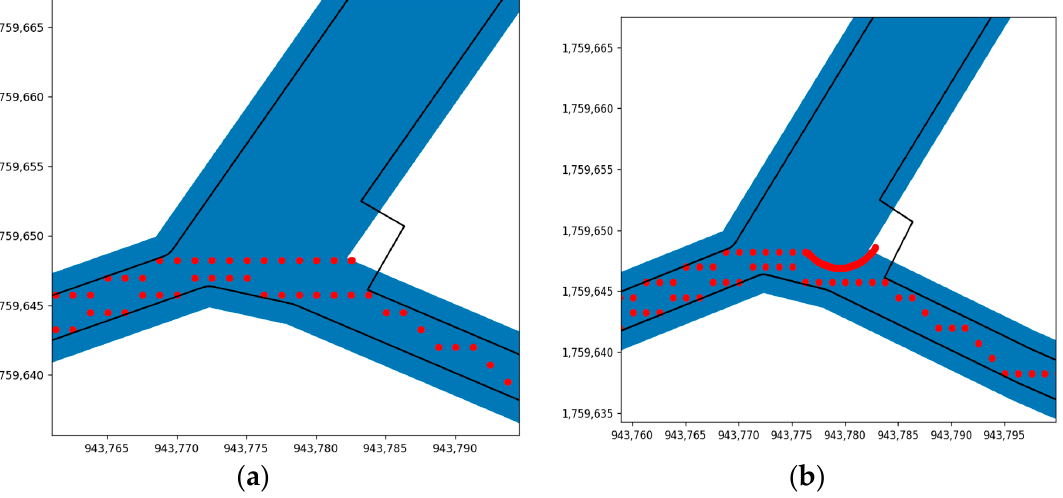
Figure 13. ( a ) A* path entering/exiting a subfield; ( b ) The Reeds-Shepp curve used to replace the A* path entering/exiting a subfield.